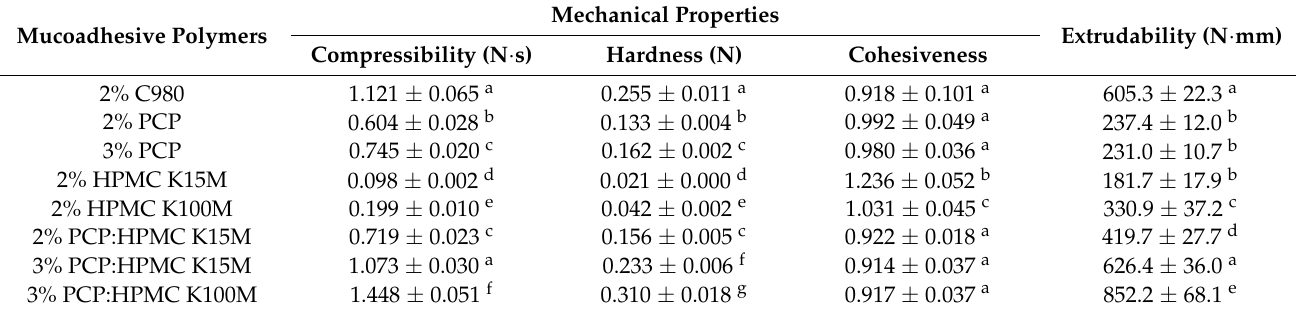
Table 3. Mechanical properties (hardness, compressibility, and cohesiveness) and extrudability of C. comosa gels at 25 ± 1 ◦ C as a function of mucoadhesive polymers. Mucoadhesive